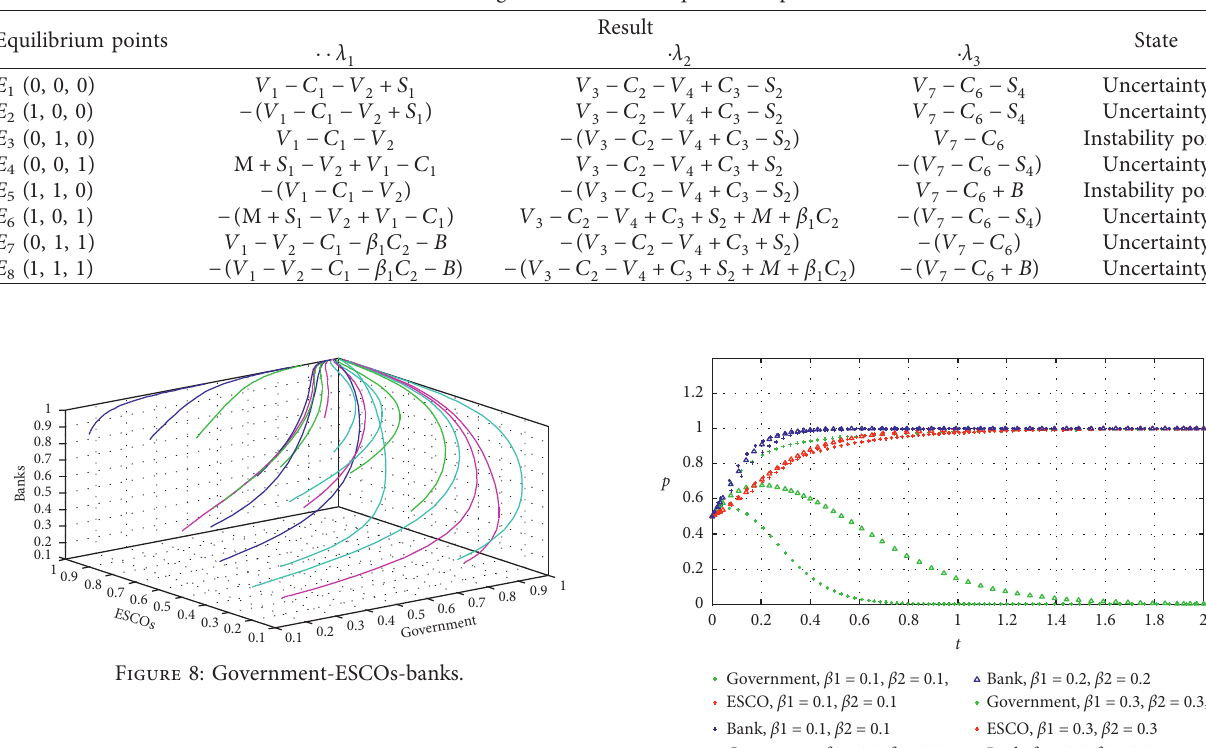
Table 4: Eigenvalues of each equilibrium point.